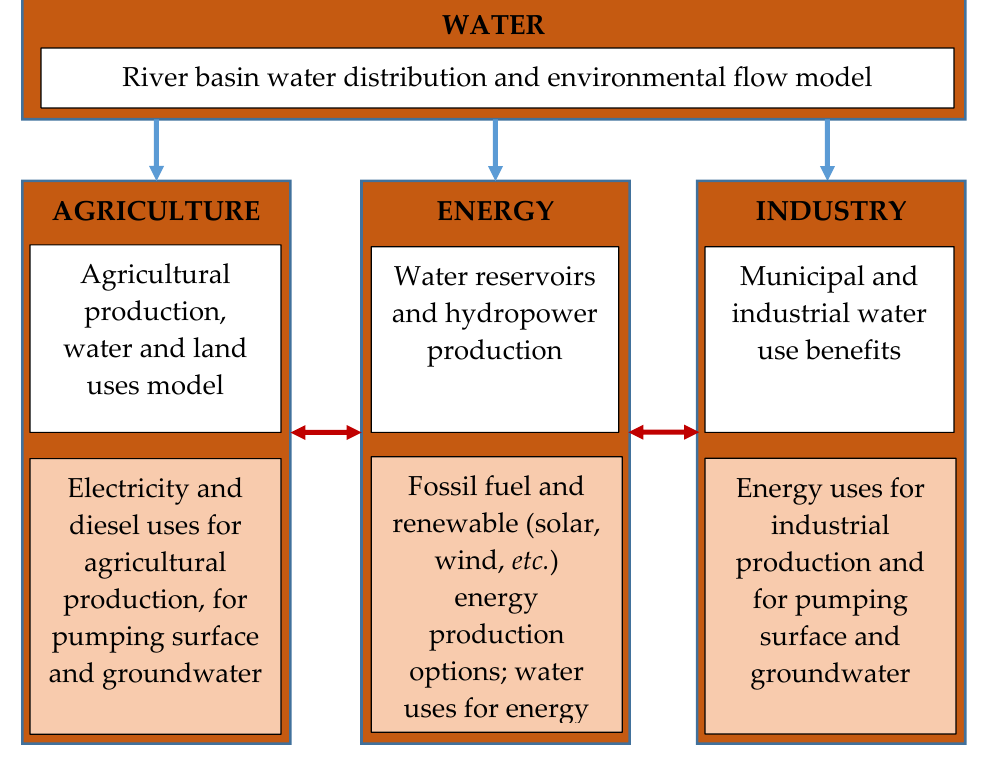
Figure 1. Main components and extensions included in the system-wide economic-water-energy model (SEWEM). Key components of existing hydro-economic models are represented in boxes with a white background (see also Bekchanov et al. [15] for a more detailed review of hydro-economic models and their shortcomings). The additional features now included in SEWEM to reflect water-energy-food/livelihood nexus linkages are represented in the boxes with a light reddish background.